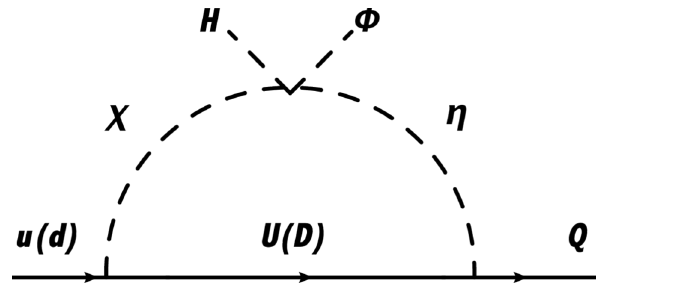
= − X l . Blue colored region realize muon g − 2 32 23